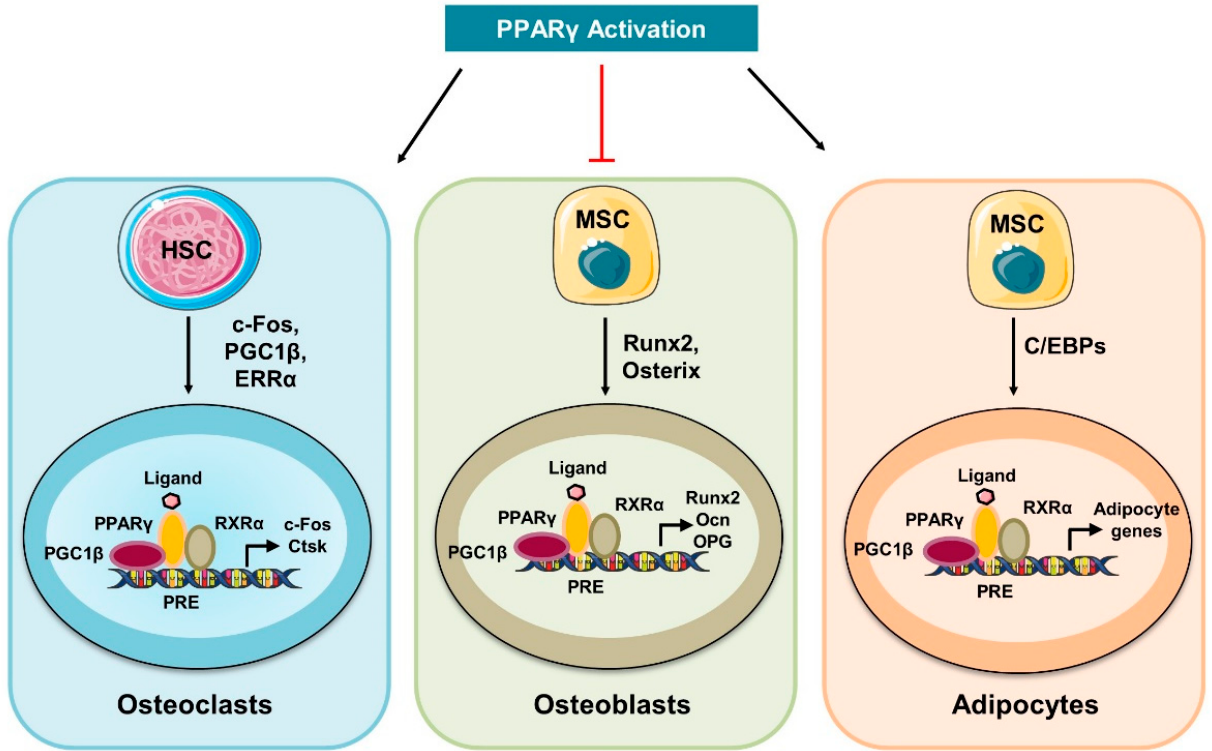
Figure 1. Activation of PPAR γ controls bone cell homeostasis: Activation of PPAR γ promotes the differentiation of HSCs to mature osteoclasts by inducing the expression of osteoclastogenic genes such as cathepsin K (Ctsk) and c-Fos. In response to ligand, activated PPAR γ forms a heterodimeric complex with the retinoic X receptor alpha (RXR α ) that further recruits the co-activators such as PGC-1 β and thus controls the expression of osteoclastogenic genes. In addition, PPAR γ inhibits the differentiation of MSCs into osteoblasts and promotes MSCs differentiation into adipocytes.